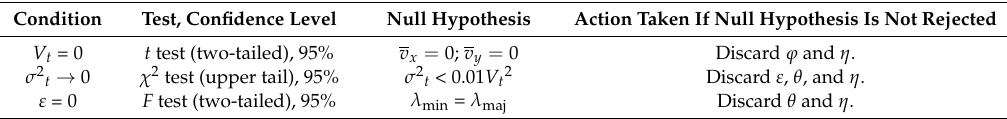
Table 1. Significance checks conducted on the computed